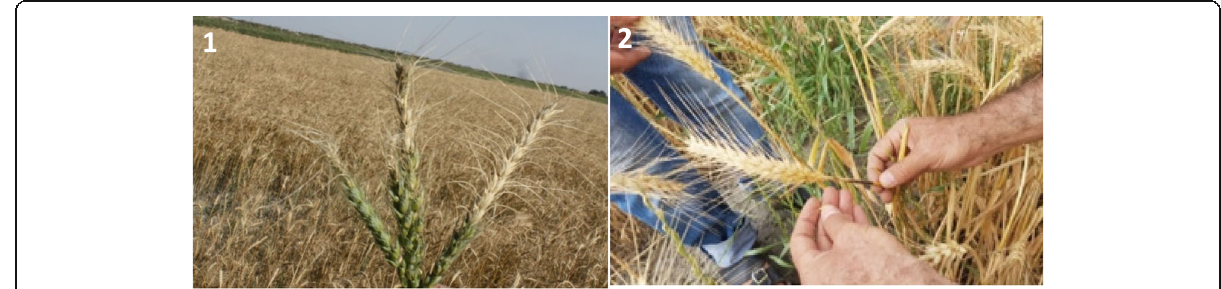
Fig. 3 Fusarium head blight (FHB) symptoms in 1 Qurna (QM) and 2 Talha (ML2) wheat